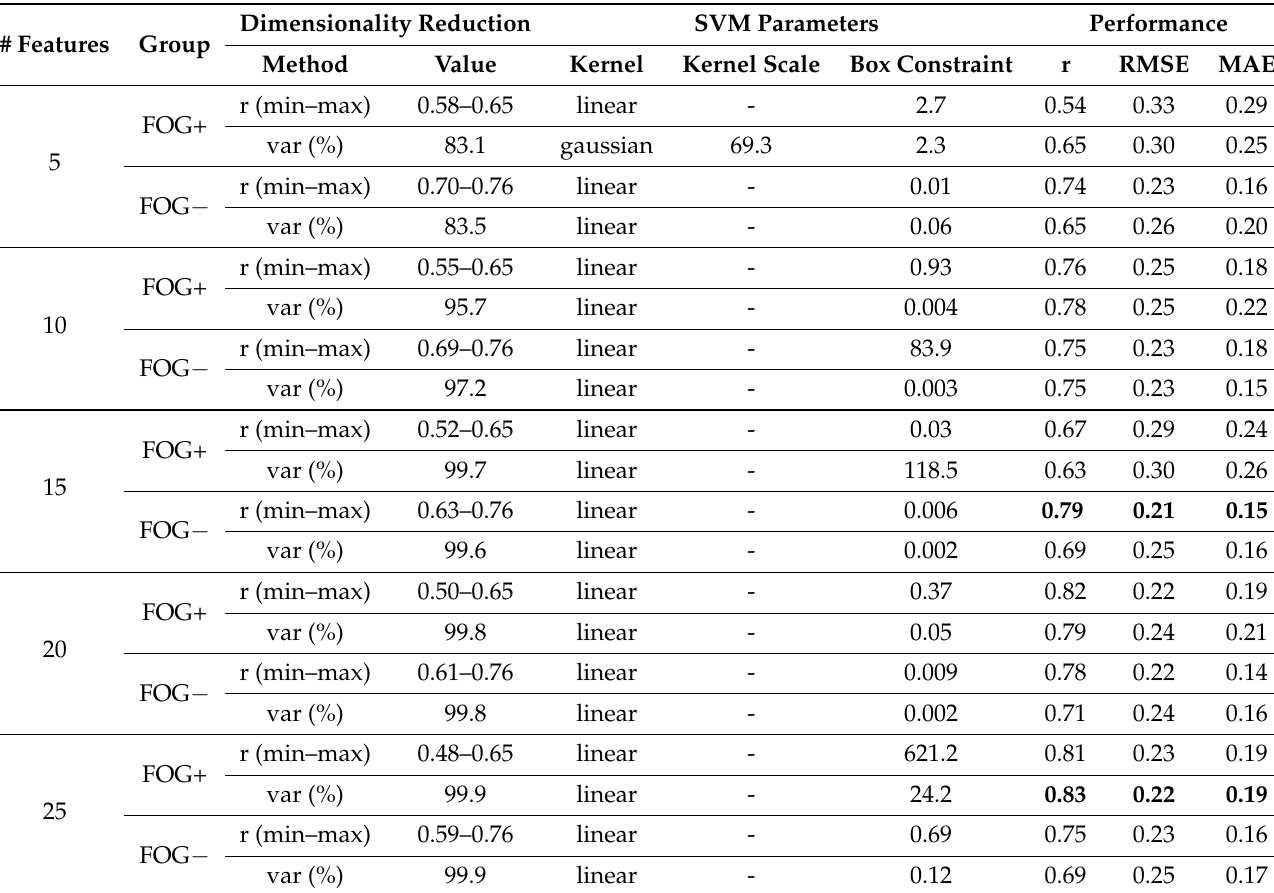
Table 10. Performance of regression models in patients with (FOG+) and without (FOG − ) freezing of gait, both not under dopaminergic therapy. Results were obtained for different feature set sizes and different dimensionality reduction methods. Best performances are marked with bold type. RMSE: root mean square error; r: correlation coefficient; MAE: mean absolute